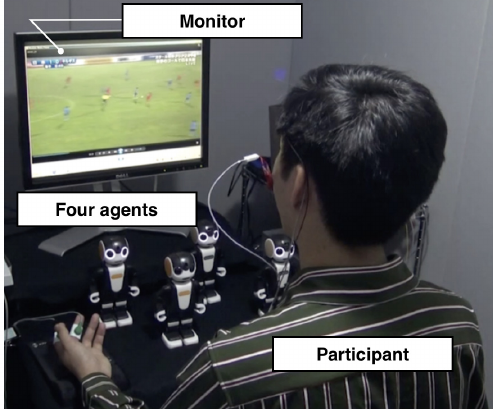
Figure 8. An overview of the soundproof